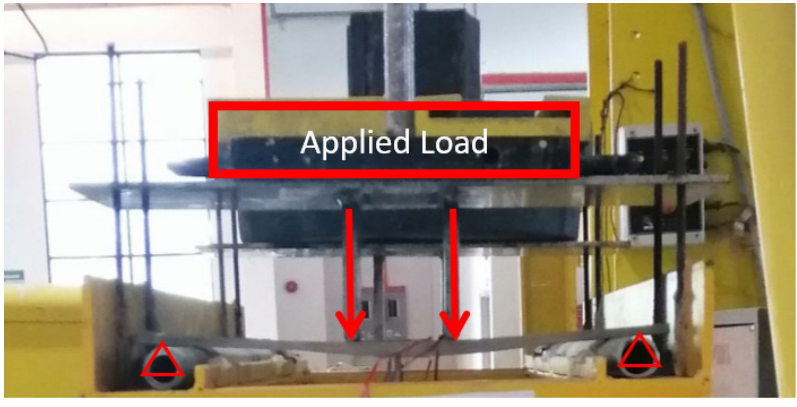
Figure 4. A coupon sample under four-point bending creep.